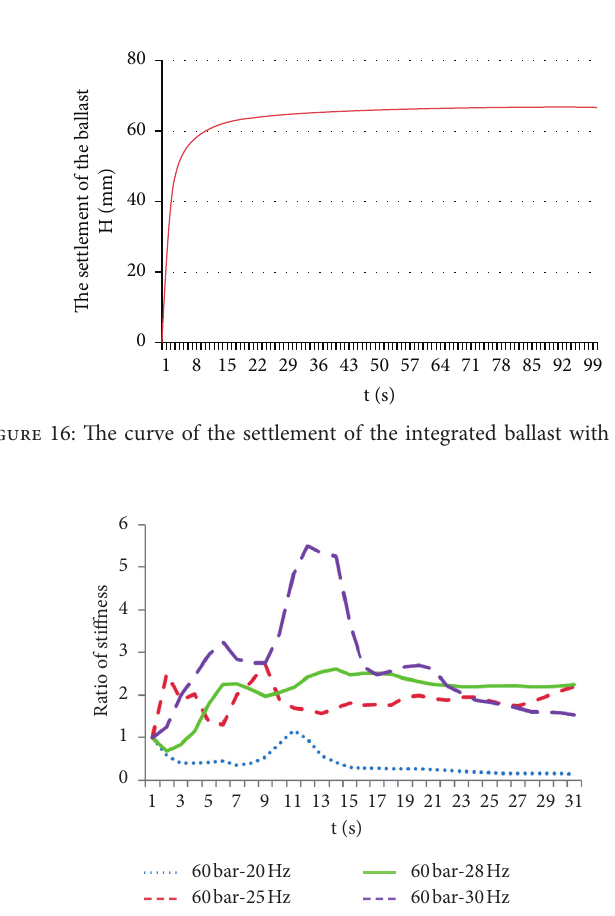
Figure 17: The curve of increase ratio of the sleeper support stiffness under different working